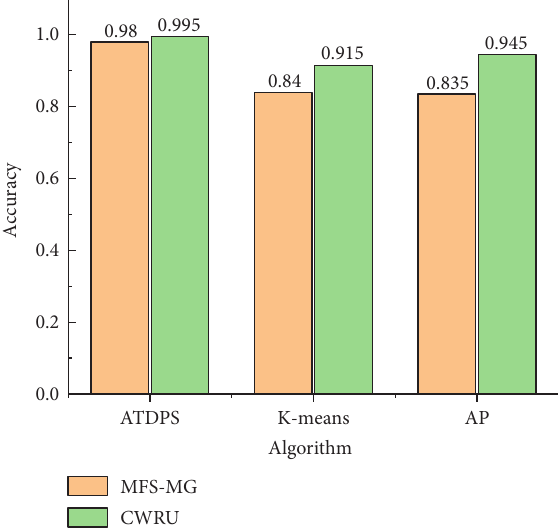
Figure 13: Accuracy of different